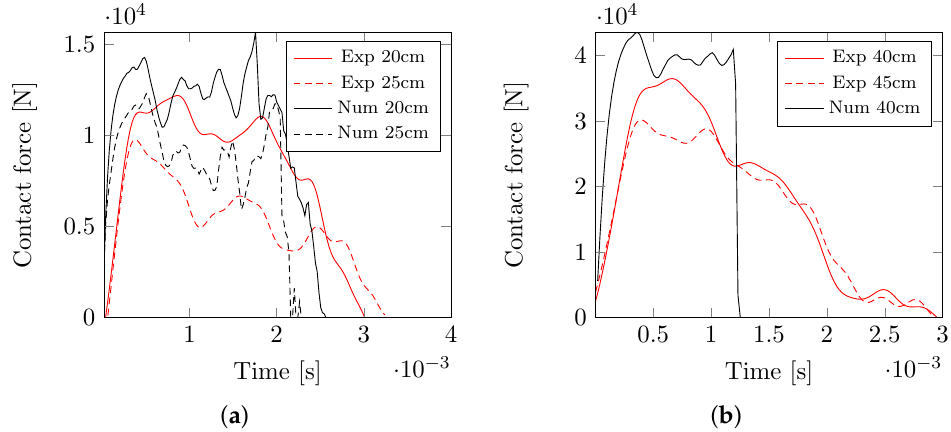
Figure 16. Comparison of evolution of measured and predicted contact force for destructive test: ( a ) 5LG-3 laminate; ( b ) 7LG-2